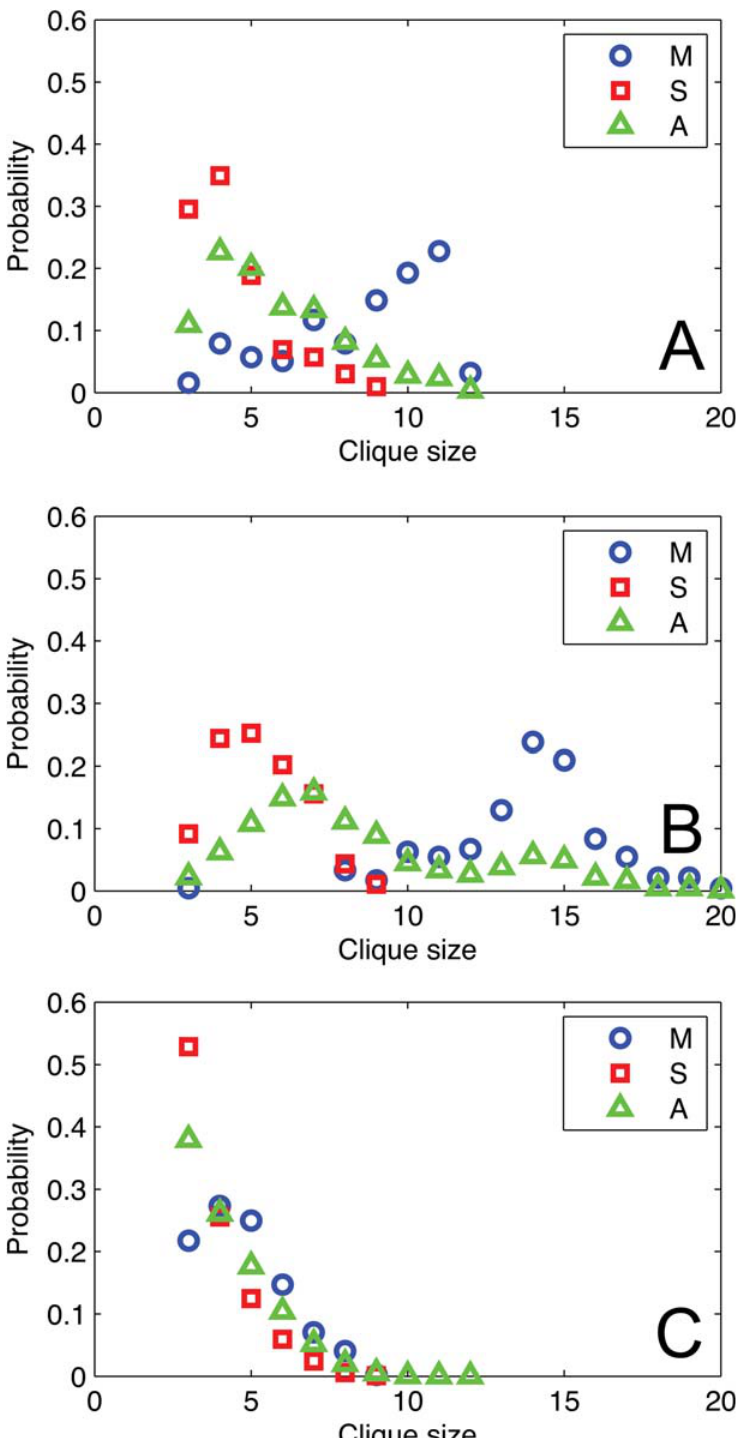
Fig 4. Social Clique vs. Social Status. Distribution of social clique in enterprise communication networks. M: Managers; S: Subordinates; A: All employees.